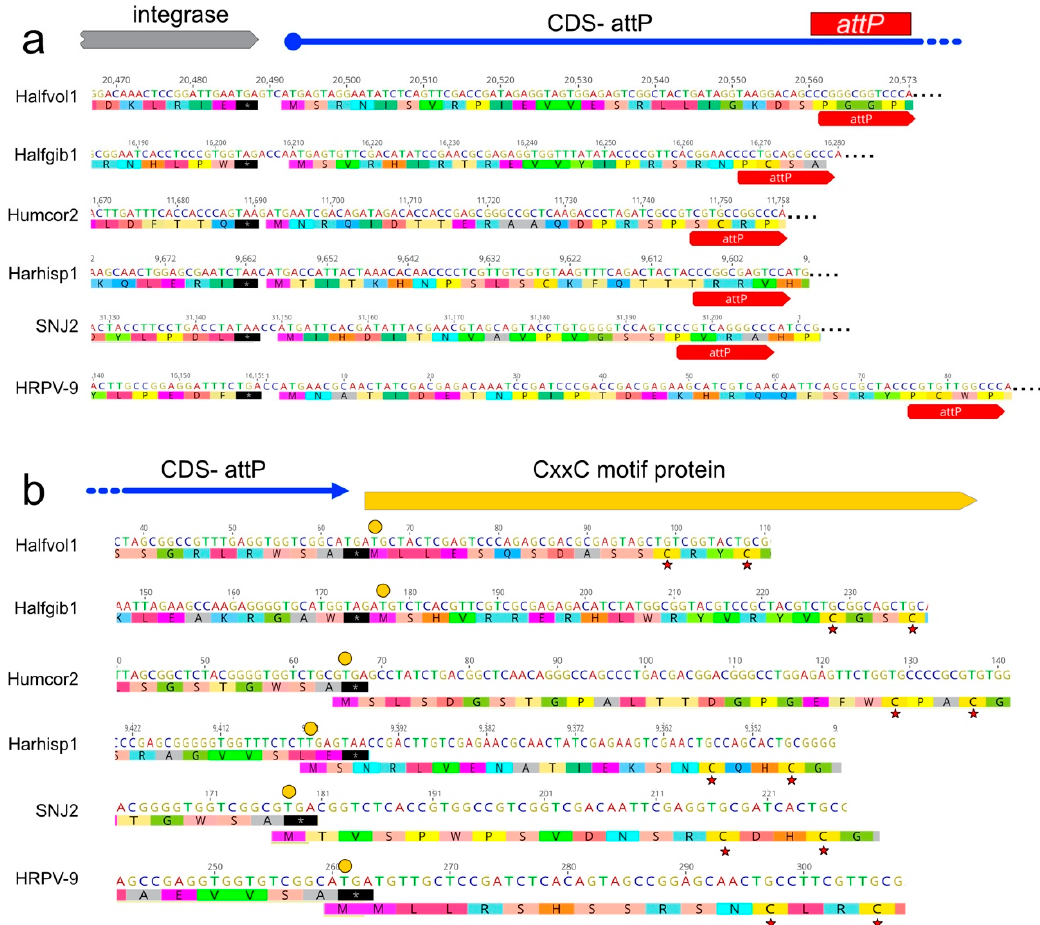
Figure 9. The attP sequence of many integrative pleolipoviruses are embedded in a CDS. Six examples are shown here: Halfvol1, Halfgib1, Humcor1, Harhisp1, SNJ2 and HRPV-9. ( a ) In each virus, the start codon of this CDS occurs near the end of the integrase gene. The translation (single letter code) and stop codon (black shading, with asterisk) are shown under the nucleotide sequence, and the position of attP is shown by the labelled red arrows. ( b ) The stop codon of the same CDS occurs near to, or overlaps with, the downstream CDS, which specifies a protein with two CxxC motifs. Start codons are indicated by yellow discs. Red asterisks point to the first CxxC motif.